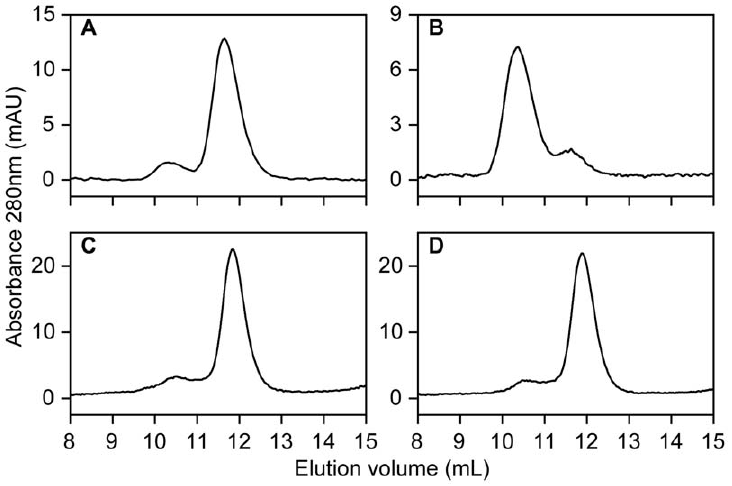
Figure 7. Superdex 75 size exclusion chromatography elution profiles of apoflavodoxin. (A) Apoflavodoxin (38 m M). (B) Apoflavodoxin (38 m M) after 22 h incubation with 10 mM H 2 O 2 at 4 u C. (C) C69A apoflavodoxin (79 m M). (D) C69A apoflavodoxin (79 m M) after 24 h incubation with